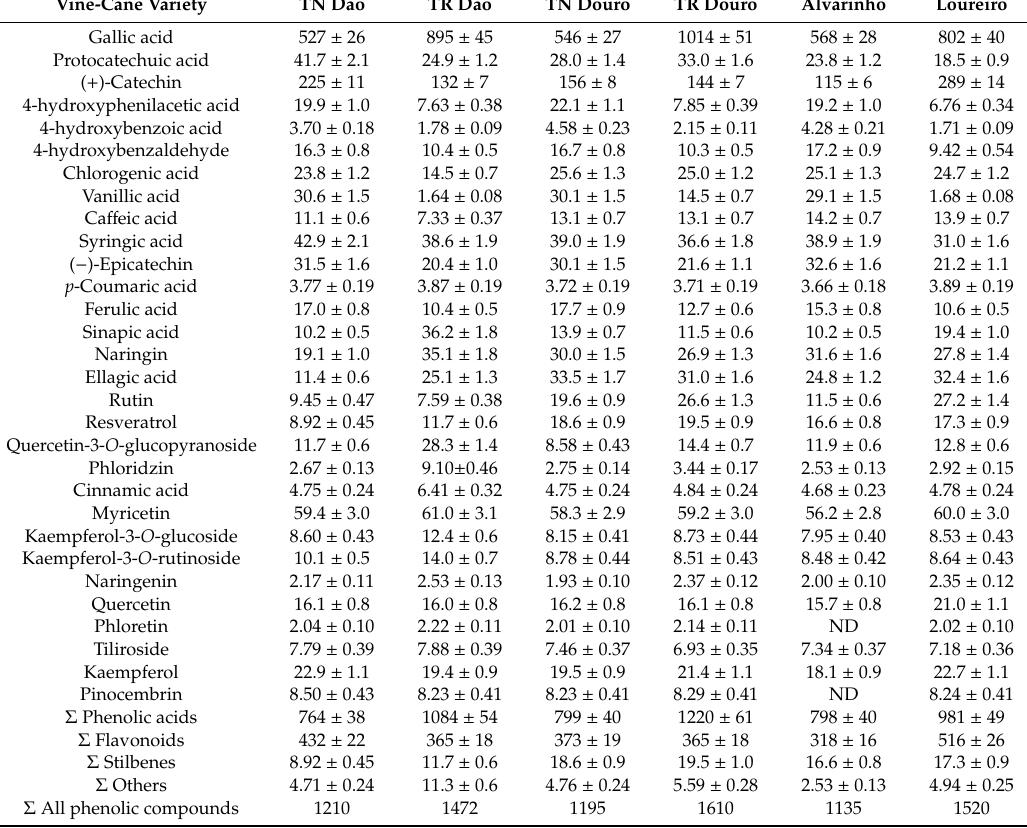
Table 2. Individual phenolic compounds identified in vine-cane subcritical water extracts; results are expressed as means ± standard deviation (mg of compound per 100 g dw, n =